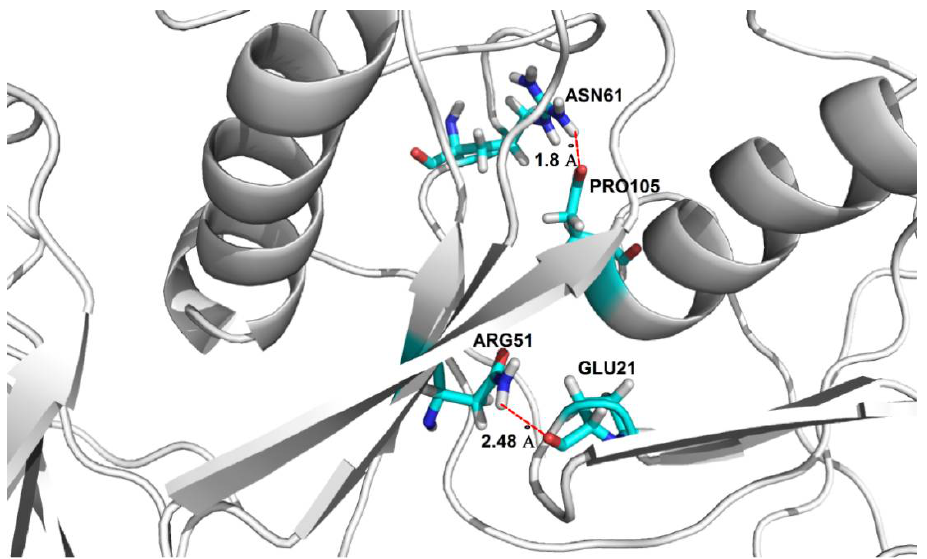
Figure 5. Location of domain-swapping hydrogen bonds stabilizing the stab-1 HCC dodecamer oligomers. Domain-swapping hydrogen bonds observed between Glu21-Arg51 and Pro105-Asn61 (represented by dotted red lines).